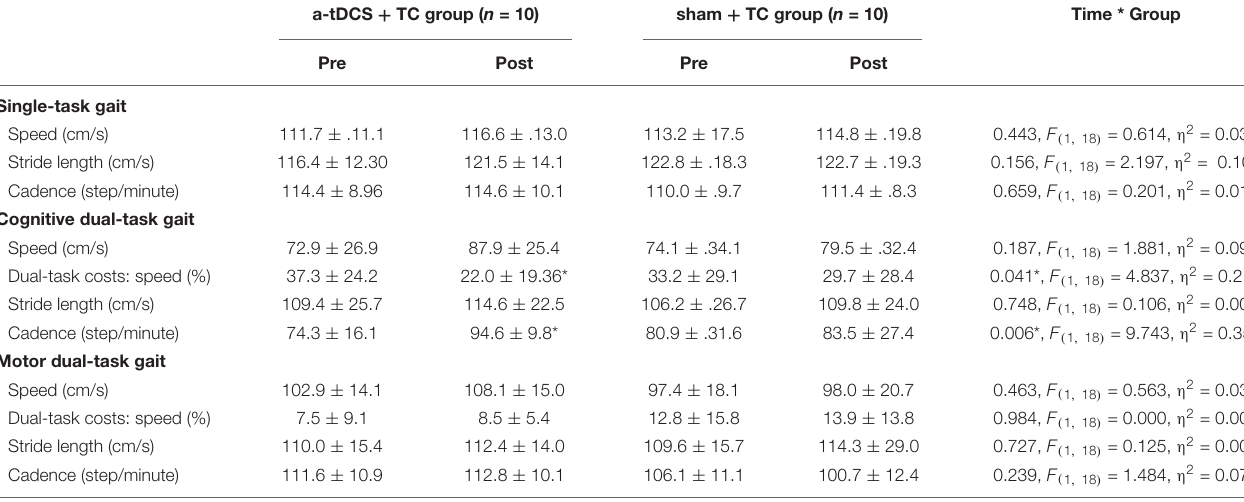
TABLE 2 | Comparisons of dual-task gait performance of the a-tDCS + TC group and sham + TC group.